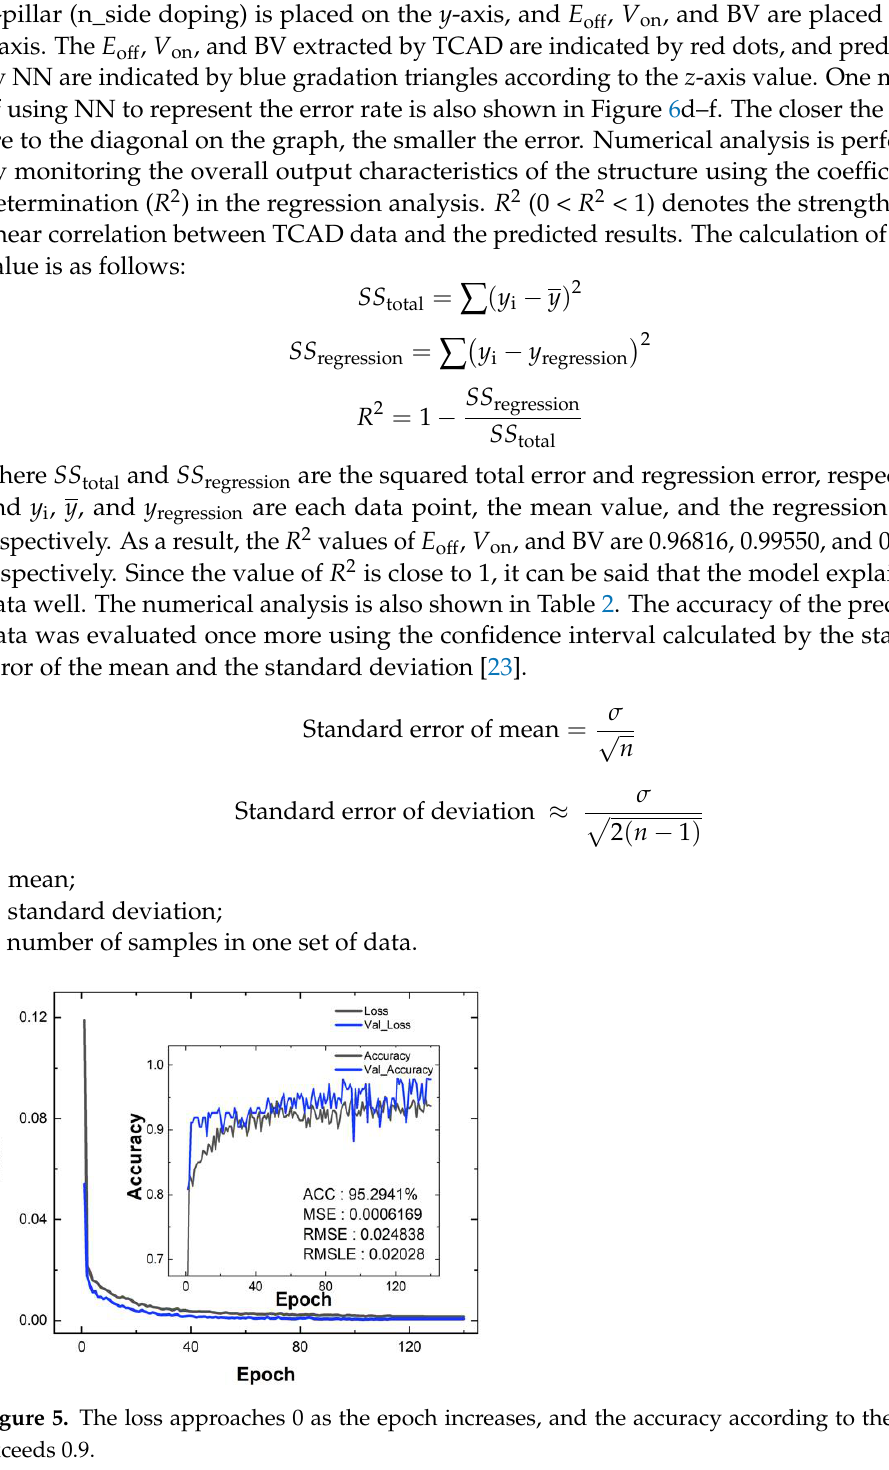
8.295 Figure 6. Test data set from TCAD versus data set predicted by ML model. There are ( a ) E off - V on , ( b ) BV- V on , and ( c ) E off -BV. Note that black-colored circles, red-colored triangles, and blue-colored re- verse triangles indicate TCAD sample, ML sample 1, and ML sample 2, respectively. E off ( g ), V on ( h ),